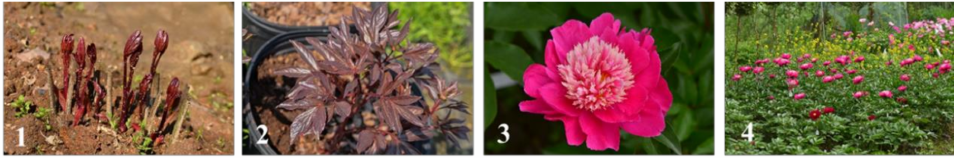
Figure 13. Growth of ‘Meiju’: From sprouting to flowering. ‘Meiju’ was planted outside at the Perennial Flower Resources Garden of Zhejiang University in Hangzhou (E 118 ◦ 21 (cid:48) –120 ◦ 30 (cid:48) , N 29 ◦ 11 (cid:48) –30 ◦ 33 (cid:48)